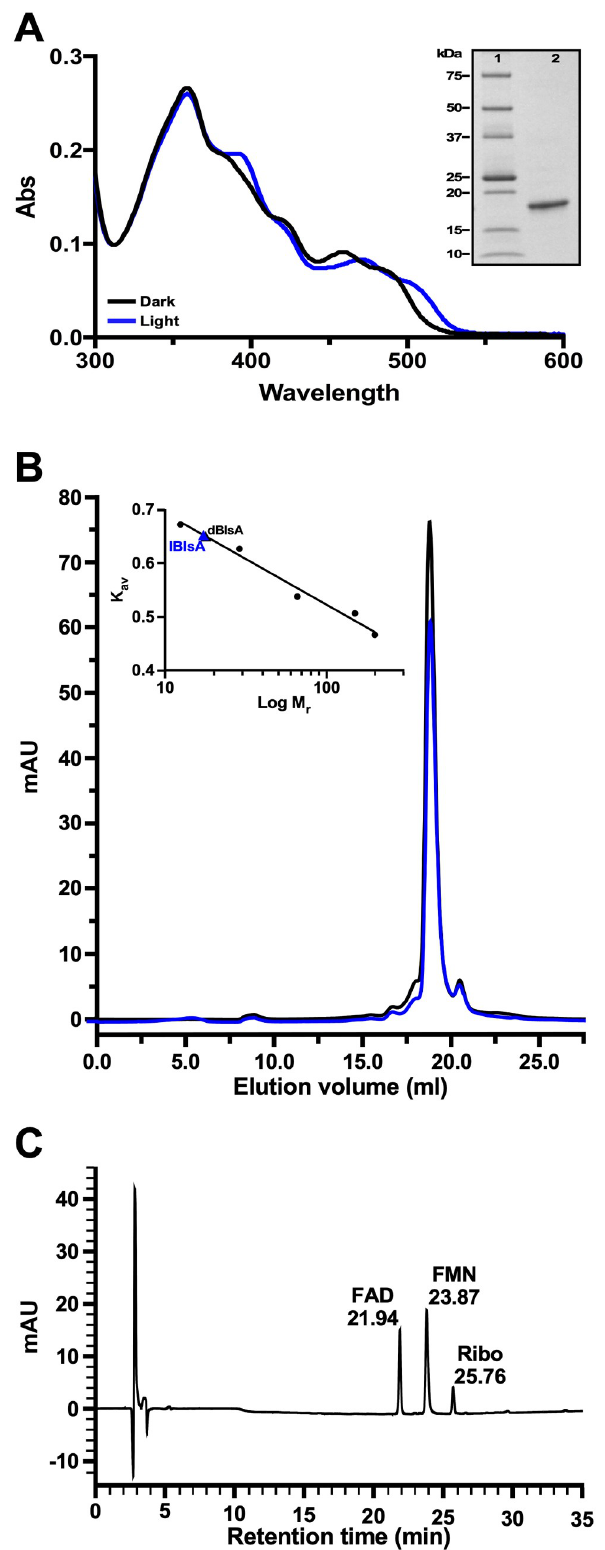
Fig 4. Analyses of His-tagged BlsA. (A) Absorption spectra of lBlsA and dBlsA. The UV-Vis light spectra were recorded using His-tagged BlsA purified by Ni-affinity chromatography and SEC. The purity of the protein sample used for spectral analyses was confirmed by SDS-PAGE using 4%-20% polyacrylamide gradient gels (inset). (B) Elution